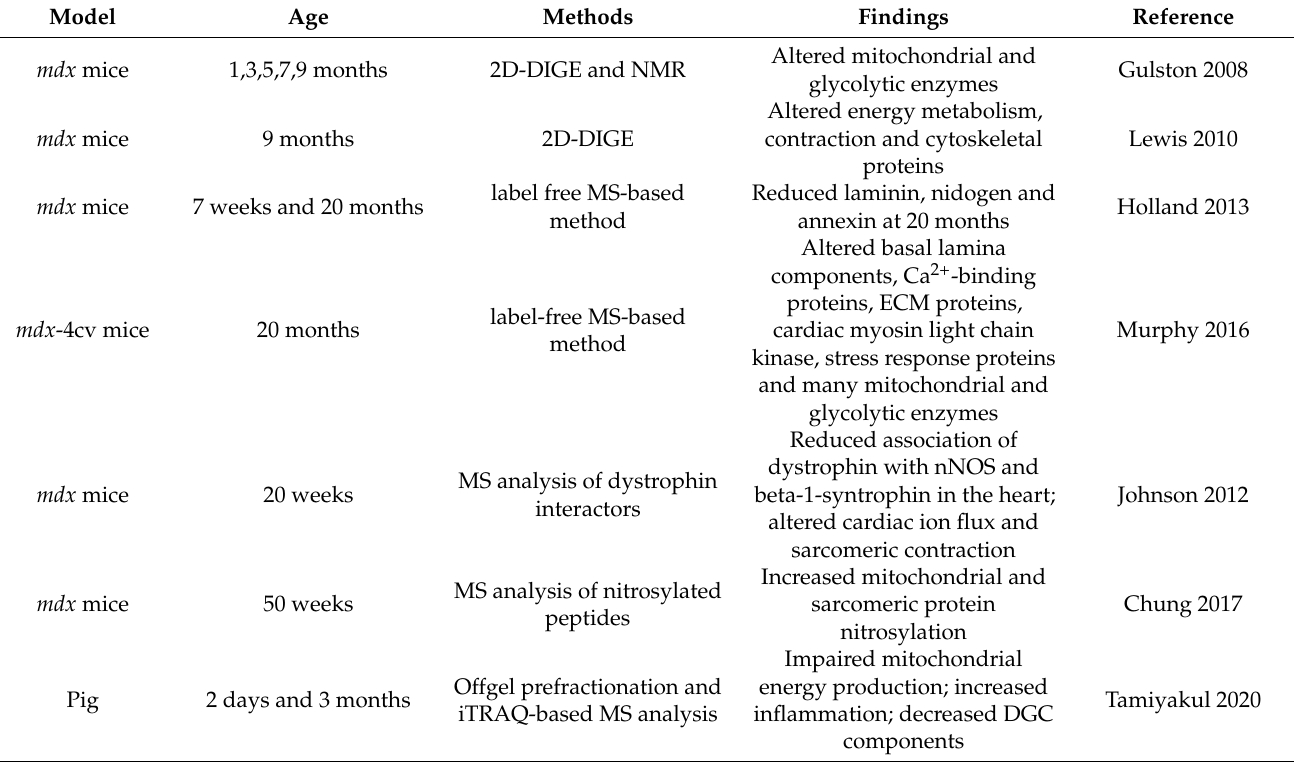
Table 1. Main studies performed on animal models of dystrophin deficiency using proteomic